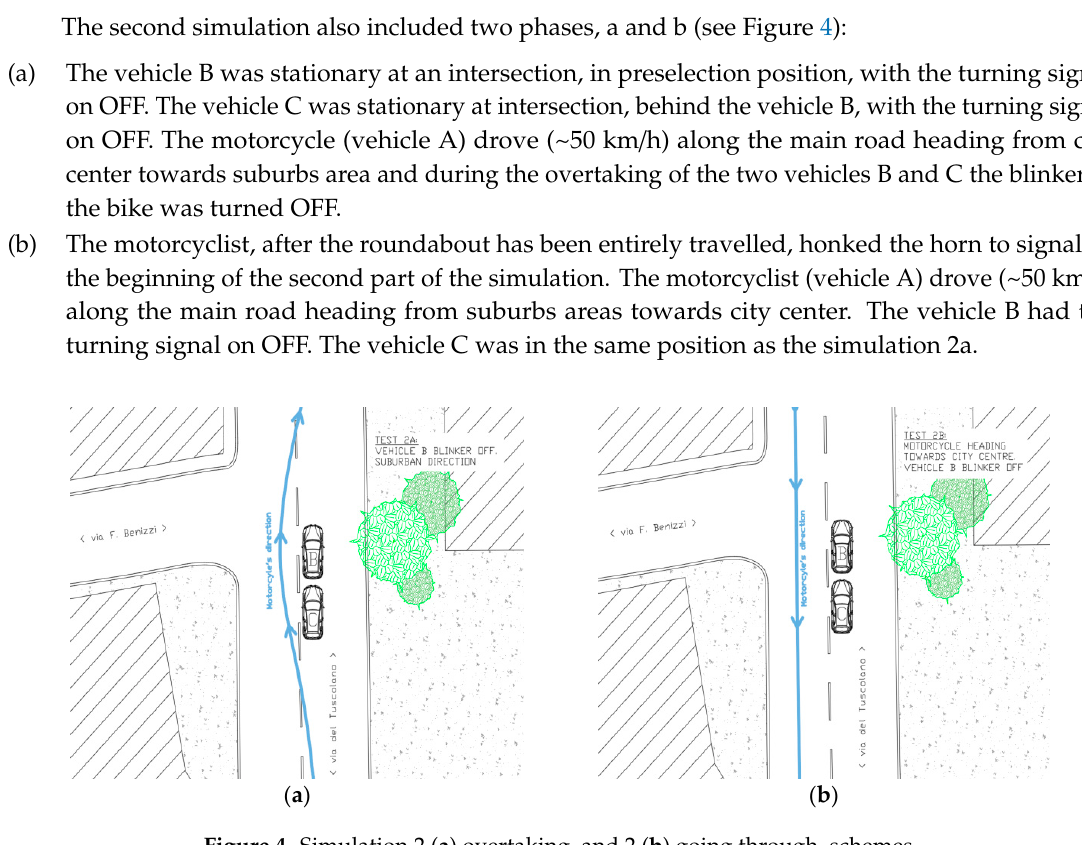
( b ) Figure 5. Simulation 3( a ) overtaking, and 3( b ) overtaking, schemes. 2.1.4. Simulation 4 (Suburban Intersection) The forth simulation was comprised of two phases, a and b (see Figure 6): (a) The vehicle B was stationary at an intersection, in preselection position, with the turning signal on ON. The vehicle C was stationary at intersection, behind the vehicle B, with the turning signal on OFF. The motorcyclist (vehicle A) drove (~50 km/h) along the main road heading westbound and during the overtaking of the two vehicles B and C the blinker of the motorcycle was turned ON. (b) The motorcyclist, after a U turn, honked the horn to report the beginning of the second part of the simulation. The motorcyclist (vehicle A) drove (~50 km/h) along the main road heading